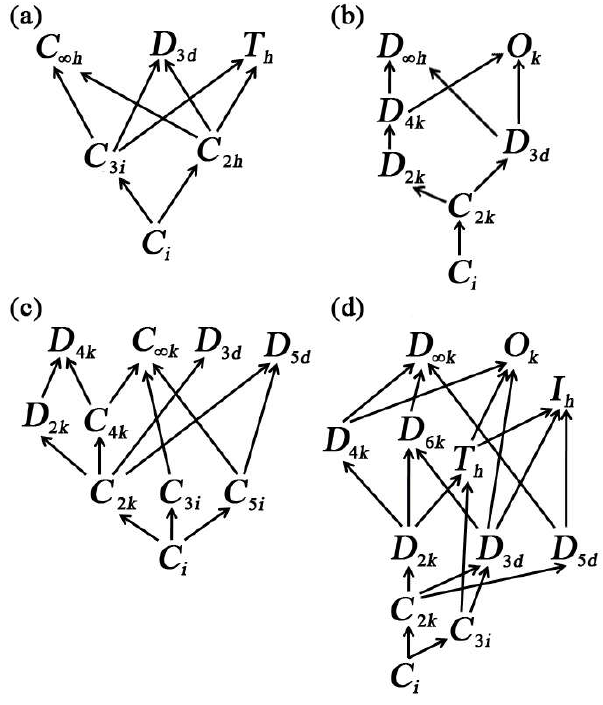
Figure 3. Characteristic web trees: ( a ) (cid:15) H ( 3 ) ; ( b ) H ( 4 ) ) ; ( c ) (cid:15) H ( 5 ) ; ( d ) H ( 6 )